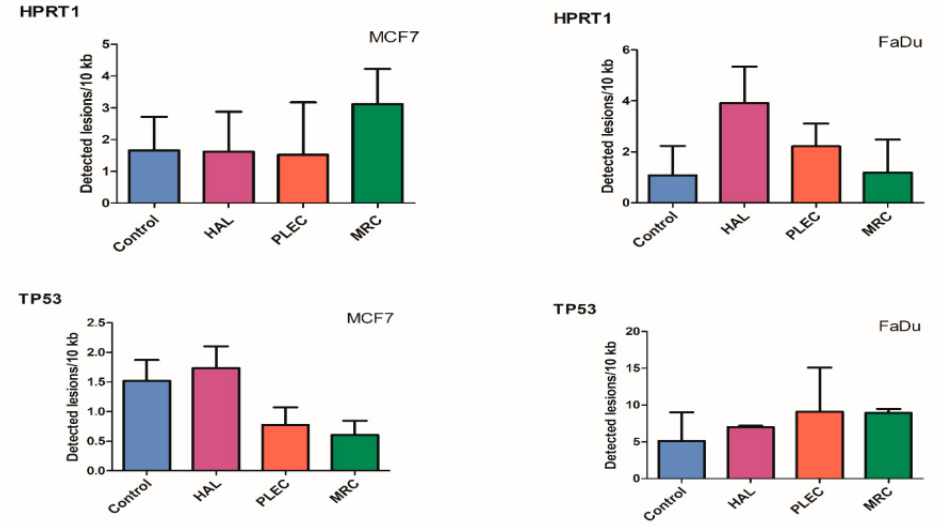
Figure 7. Quantification of nuclear DNA (nDNA) lesion frequency per 10 kb DNA by SLR-qRT-PCR amplification of total DNA from MCF7 and FaDu cells exposed to HAL, PLEC and MRC for 24 h. Data represents the mean ± SD of three replicates.